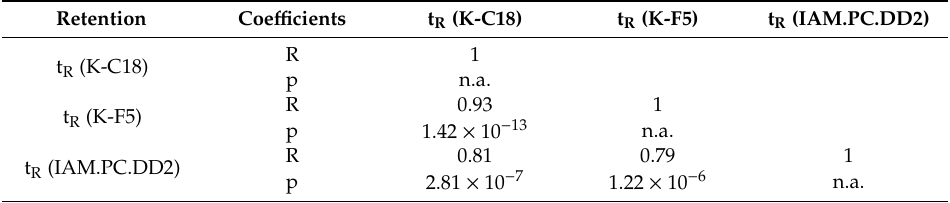
Table 1. Univariate retention time correlation matrix for the three evaluated